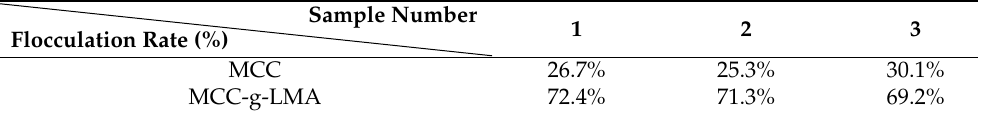
Table 5. Extraction and enrichment of vitamin K 2 from MCC and MCC-g-LMA flocculation